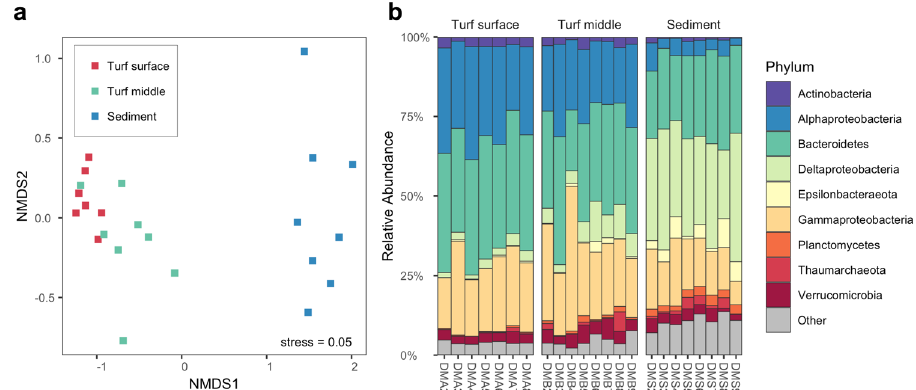
Fig. 6 Microbial community structure associated with turf algae. a nMDS plot of microbial community structure associated with turf algae based on Bray – Curtis dissimilarity ( n = 8 biologically independent locations). Colours indicate the position within and below the turf algal mat from which samples were collected. b Stacked bar plot of microbial community composition at the phylum level and Proteobacterial class level. The nine most abundant phyla based on total number of reads are displayed, additional phyla are grouped as ‘ Other ’ .